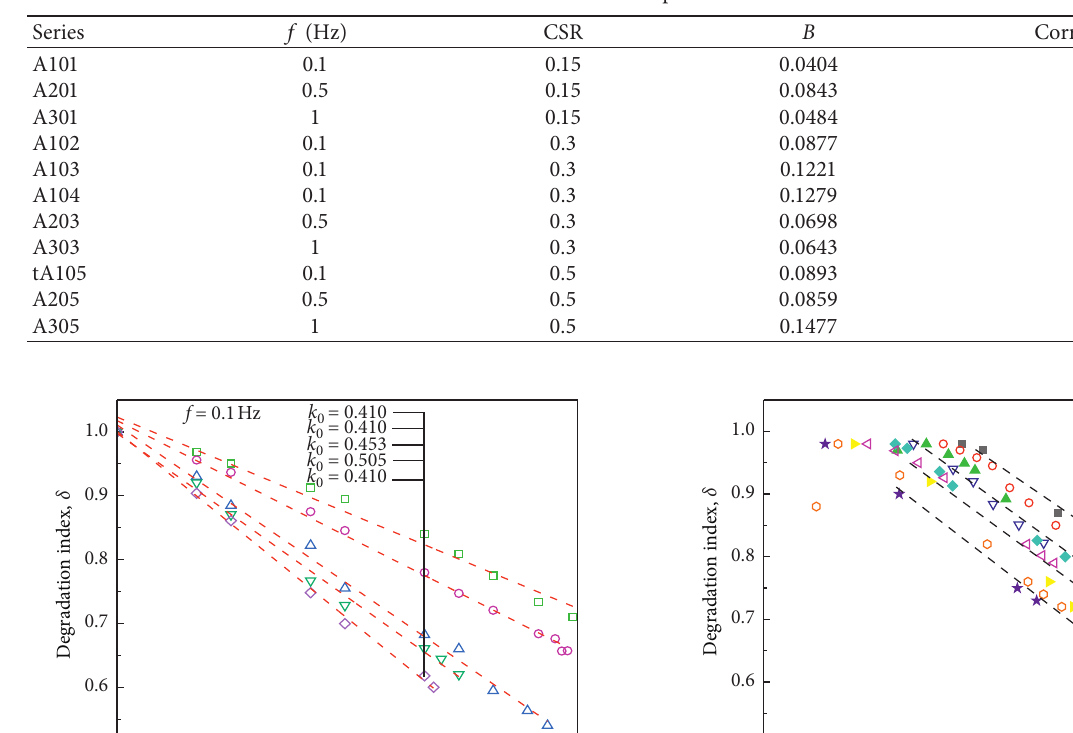
Table 5: Test parameters.